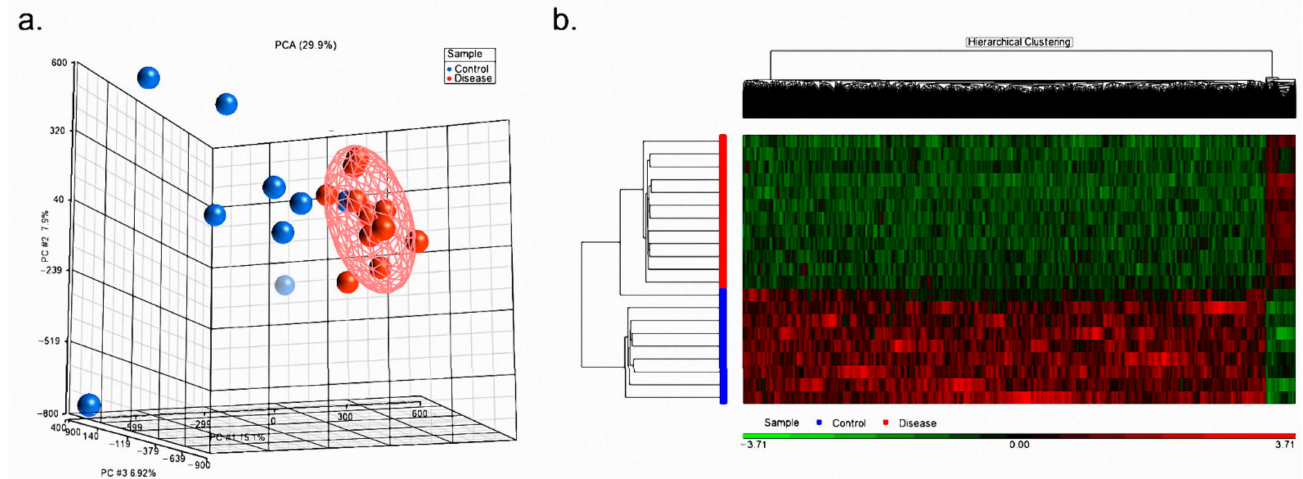
Figure 1. The overall DNA methylation patterns were derived from the M850K analysis. Blue and red dots (bars) denoted the control (healthy control) and disease (ADHD) subjects, respectively. ( a ) The PCA plot reflected the overall DNA methylation patterns of samples. The disease samples were aggregative more than the control samples. ( b ) The heat map reflected the variations of the significant CpG dinucleotides. Almost 95% of significant CpG dinucleotides were hypo-methylated in the disease